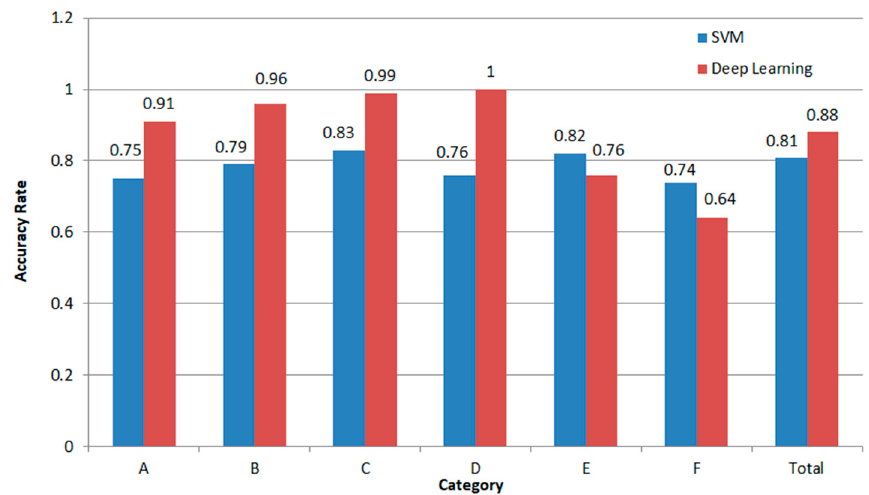
Figure 10. Accuracy comparison of deep learning algorithm and Support Vector Machine algorithm in RF signal state classification.